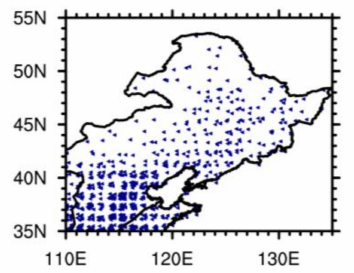
Figure 1. Locations of the 673 stations in Northeast China (NEC) in this